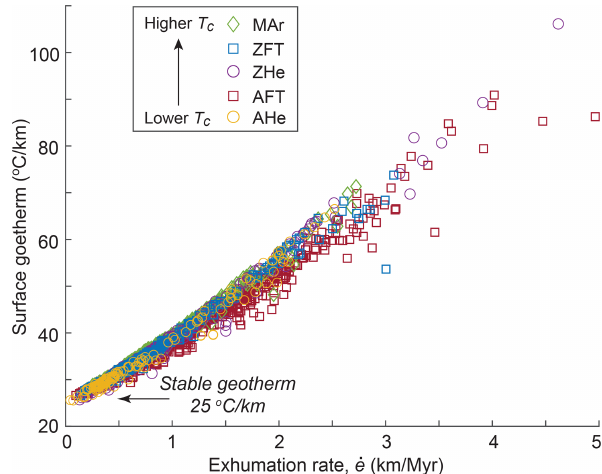
Figure 6. Predicted surface geothermal gradient as a function of predicted steady-state exhumation rate for all Himalayan data. Input linear geotherm G init = 25 ◦ Ckm − 1